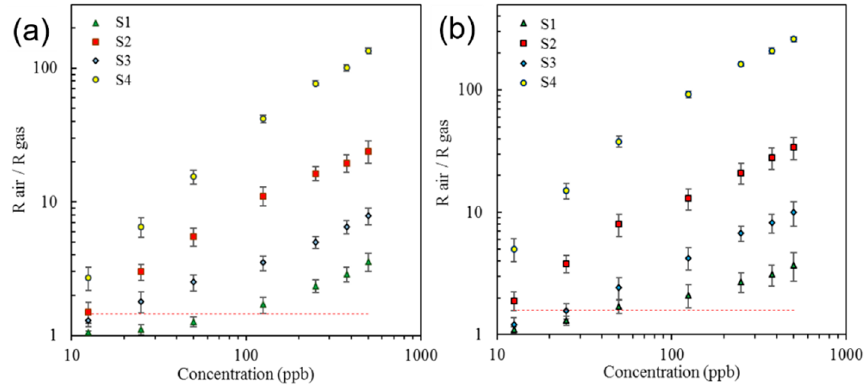
Figure 16. Sensor responses to different concentrations of ( a ) benzene and ( b ) toluene in a range between 12.5 and 500 ppb. The horizontal dashed line shows the detection threshold.